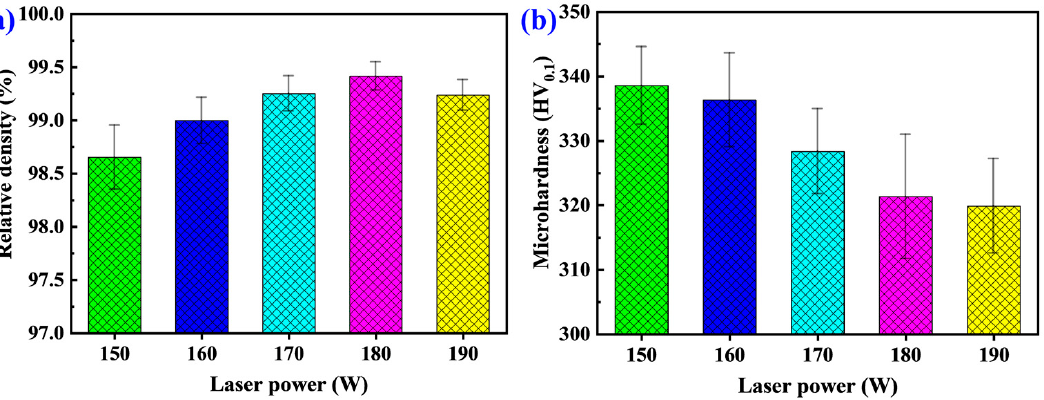
Figure 2. The density ( a ) and microhardness ( b ) of as-LPBFed TA15 titanium alloy under various laser powers.